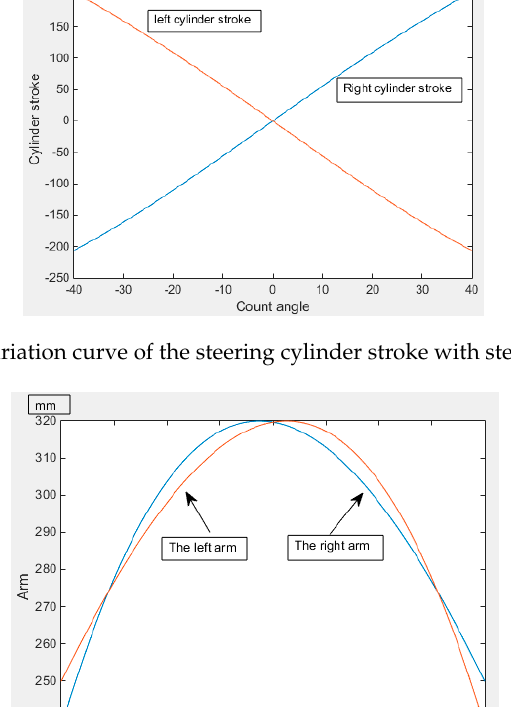
Figure 7. Curve of the arm of force difference of a cylinder with steering angle. Algorithms 2019 , 12 , x FOR PEER REVIEW